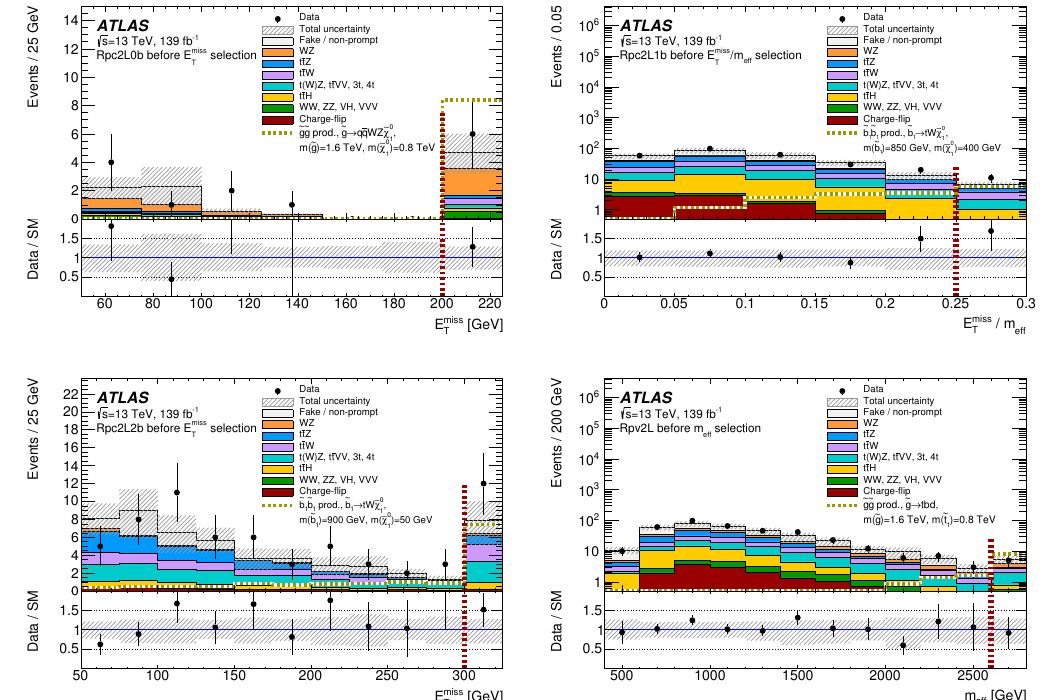
Figure 5. Distributions of E miss , m e(cid:11) or the E miss =m e(cid:11) ratio near the SRs (top left) Rpc2L0b , T T (top right) Rpc2L1b , (bottom left) Rpc2L2b and (bottom right) Rpv2L . The total uncertainties in the expected event yields are shown as the hashed bands. The last bin, isolated by a vertical red dashed line, is inclusive and corresponds to the SR. Hypothetical contributions from representative SUSY scenarios are displayed by the dashed-line overlaid histograms.